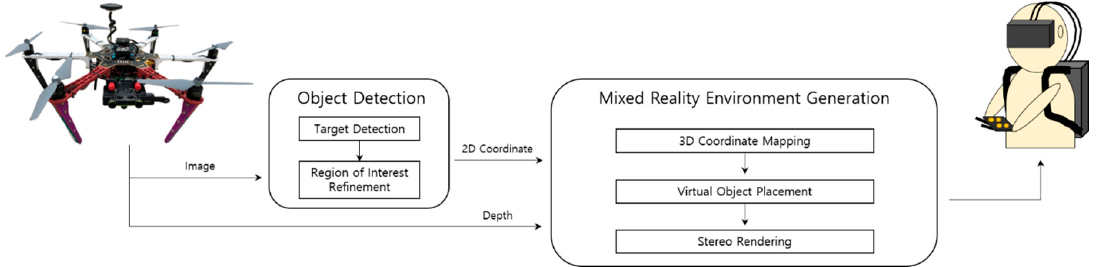
Figure 1. Software architecture of the proposed system.